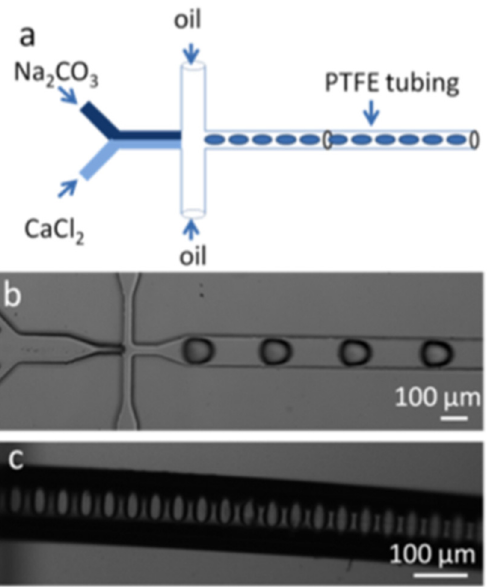
Figure 5. ( a ) Schematic of the Y-shaped microfluidic system used for the segmented flow synthesis of calcium carbonate. Droplets are generated by an FC-40 oil flow from the additional channels. ( b ) Bright-field Image of droplets. ( c ) Image of aqueous droplets of calcium carbonate. Image reproduced from Yashina, A. et al., with permission from Biomicrofluidics [53]. Polymorph compositions of the resulting calcium carbonate were shown to be